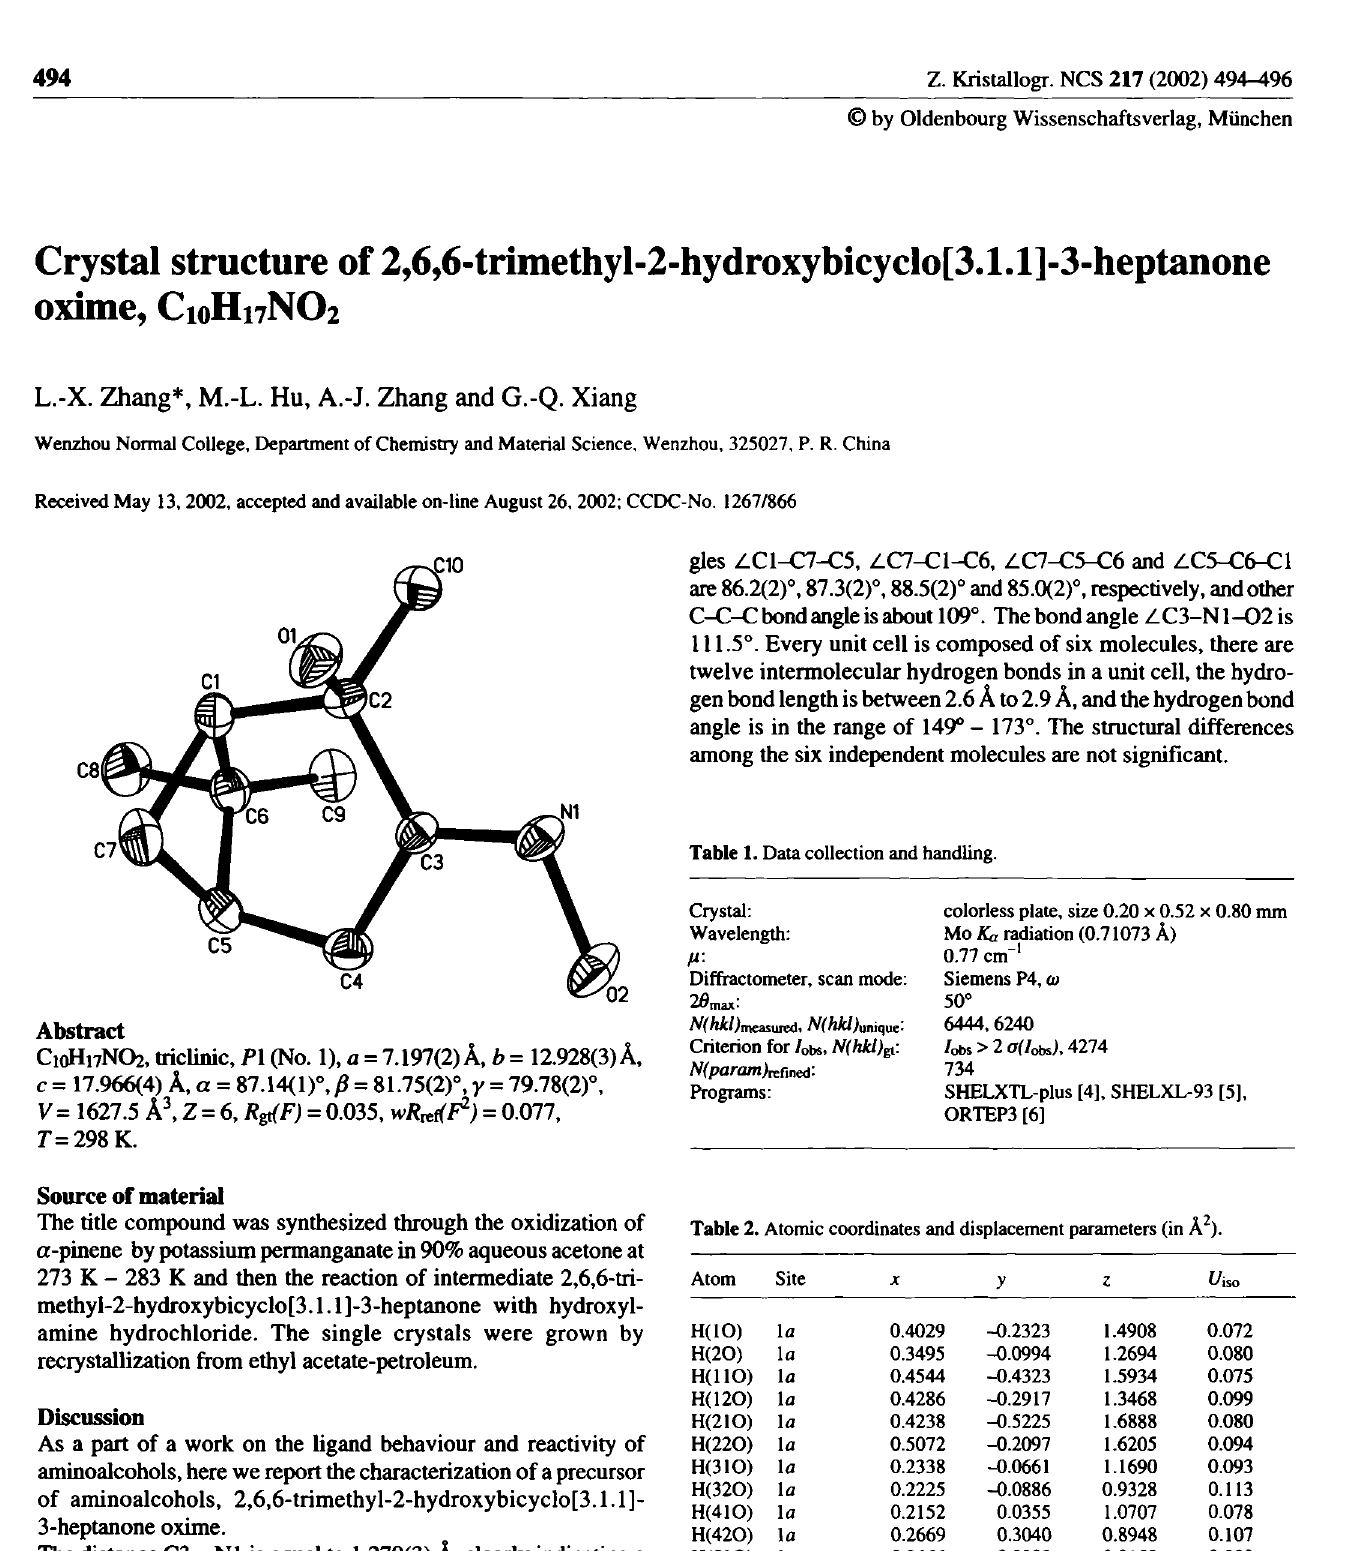
Table 2. Atomic coordinates and displacement parameters (in Â 2